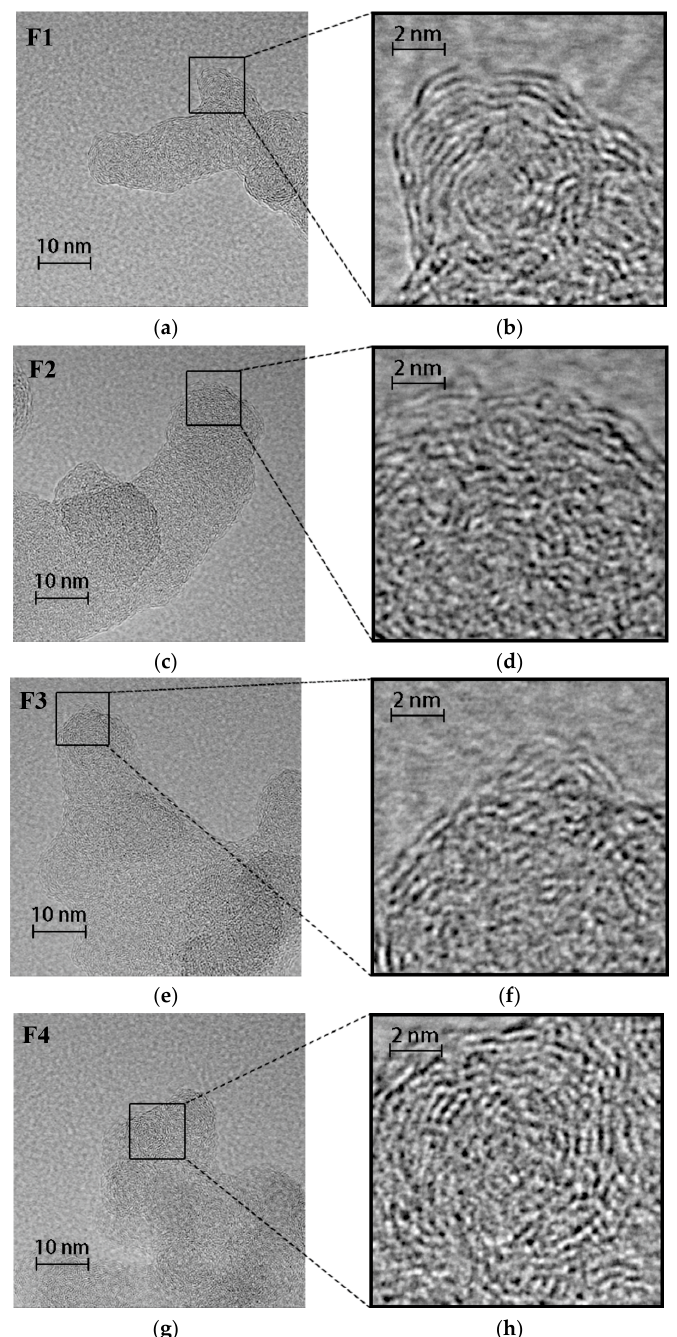
Figure 3. Initial HRTEM images at high magnification of nascent soot particles and partial enlarged images of soot particles under different conditions: ( a ) initial HRTEM image of pure ethylene; ( b ) partial enlarged image of F1; ( c ) initial HRTEM image of 1-pentanol/ethylene; ( d ) partial enlarged image of F2; ( e ) initial HRTEM image of 3-methyl-1-butanol/ethylene; ( f ) partial enlarged image of F3; ( g ) initial HRTEM image of 2-methyl-1-butanol/ethylene; ( h ) partial enlarged image of